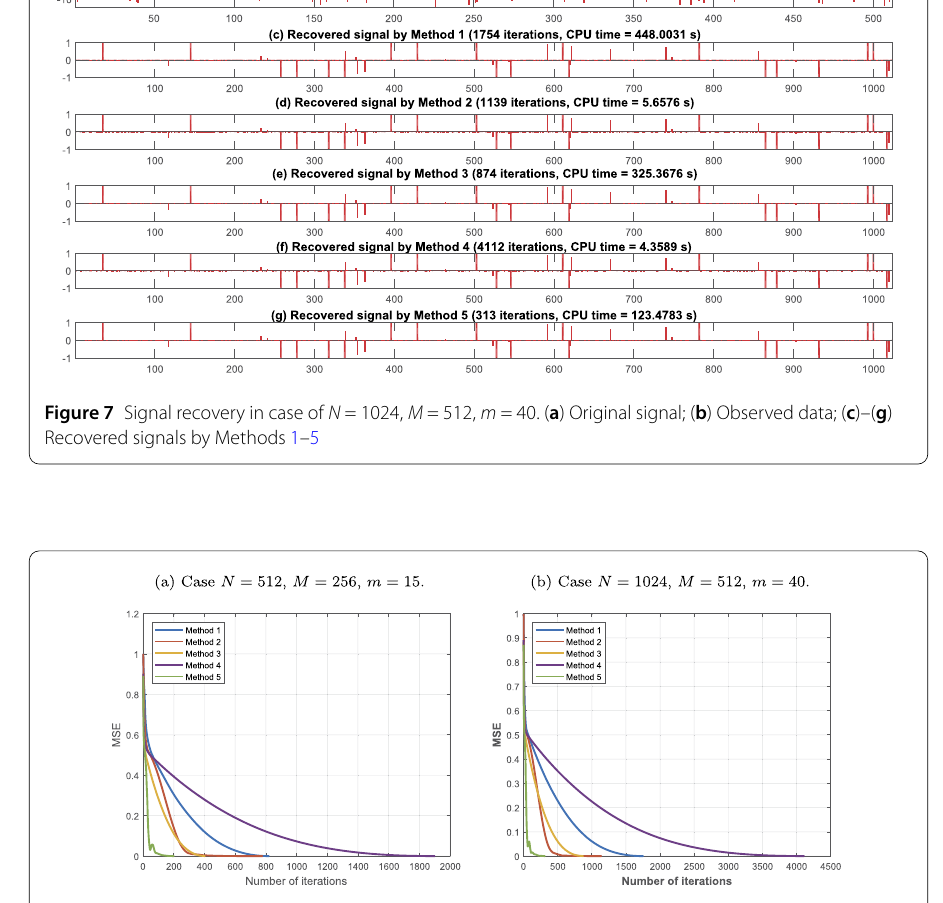
Figure 8 The MSE versus the number of iterations for recovering the signals by Methods